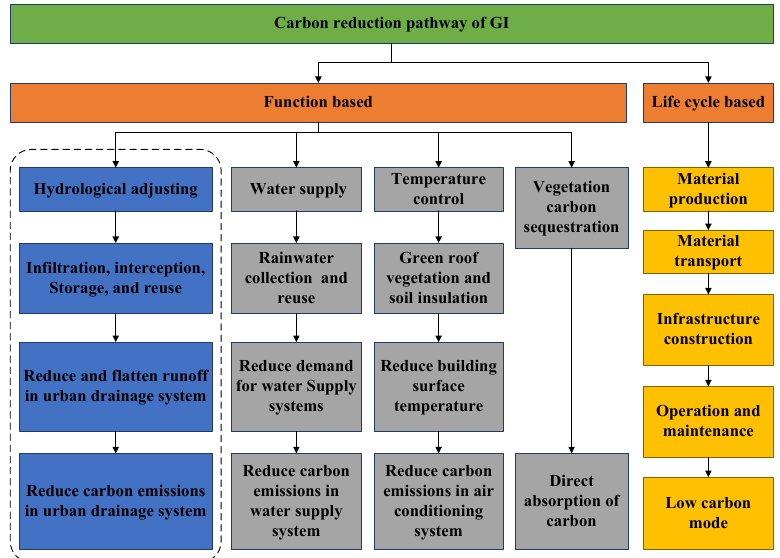
Figure 4. Carbon reduction pathway of GI based on the functionality and life cycle [31–33,46,50–52]. The figure represents a summary of the cited references.